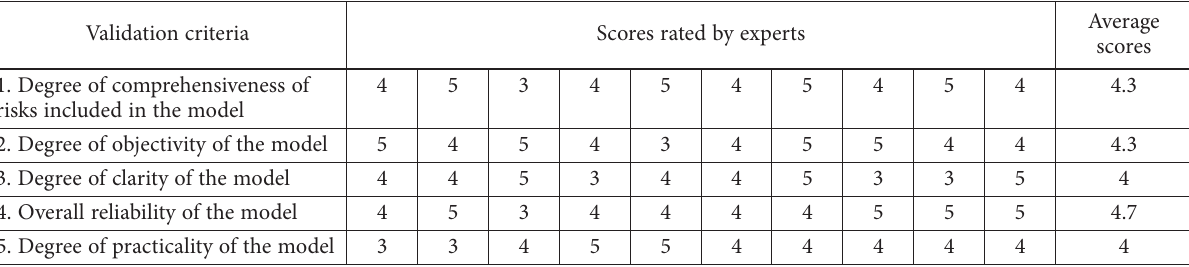
Table 11. Results of validation exercise for SWARA-COPRAS risk allocation model Validation